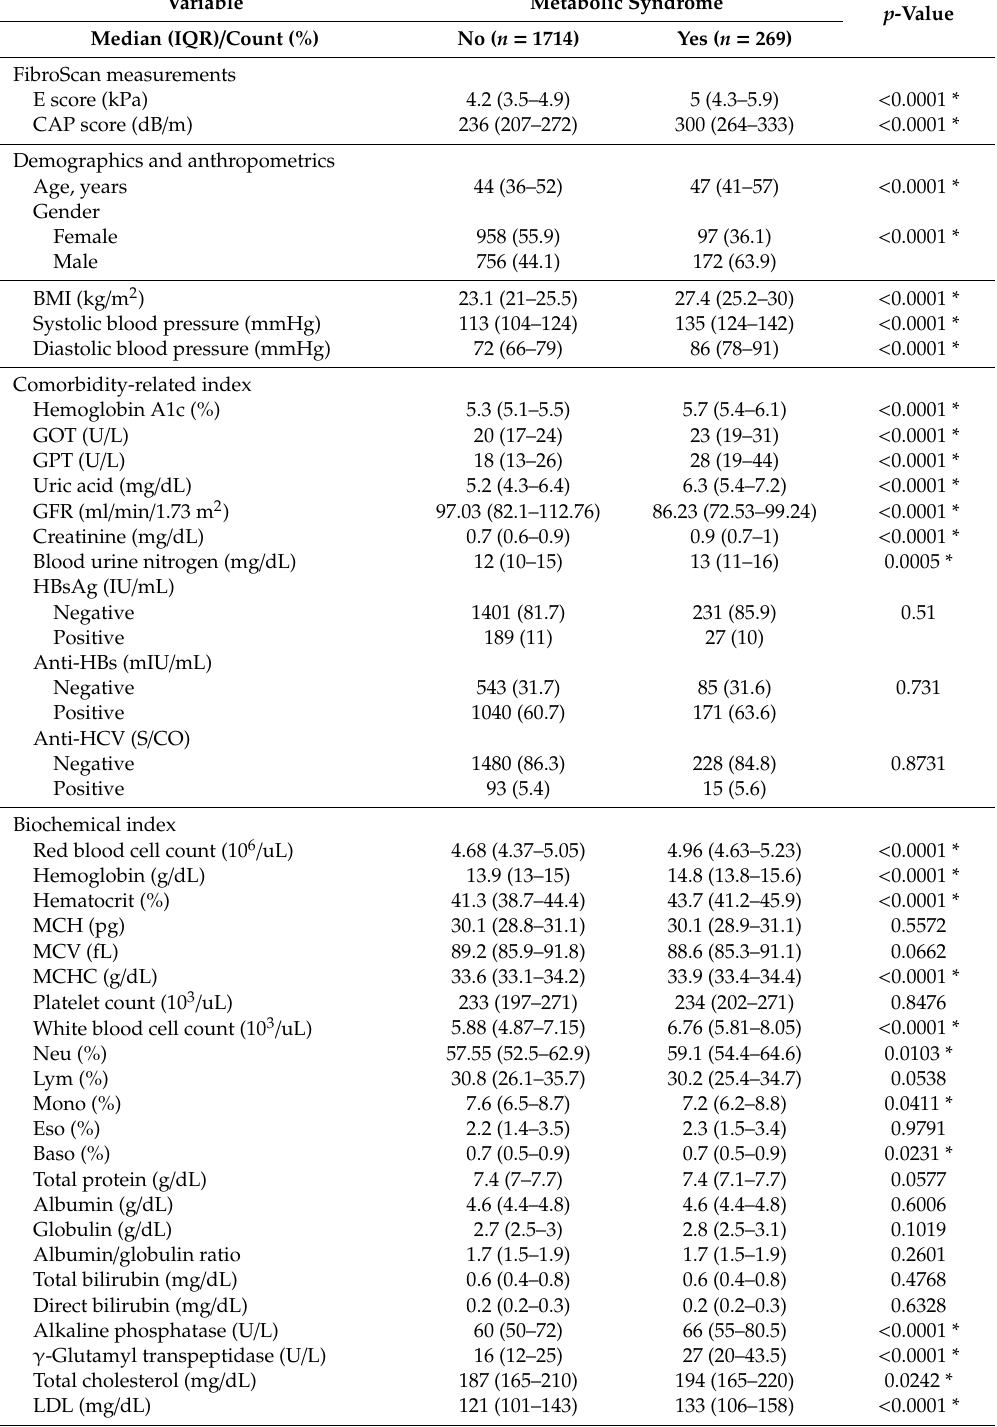
Table 1. Summary of the study sample characteristics by metabolic syndrome status ( n =